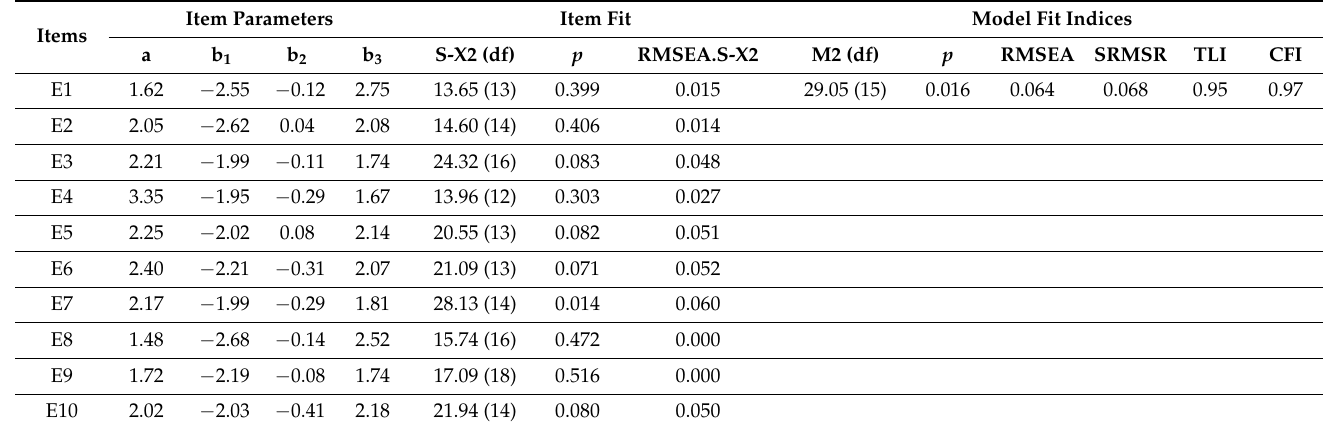
Table 2. Discrimination parameters and location for the items of each dimension.